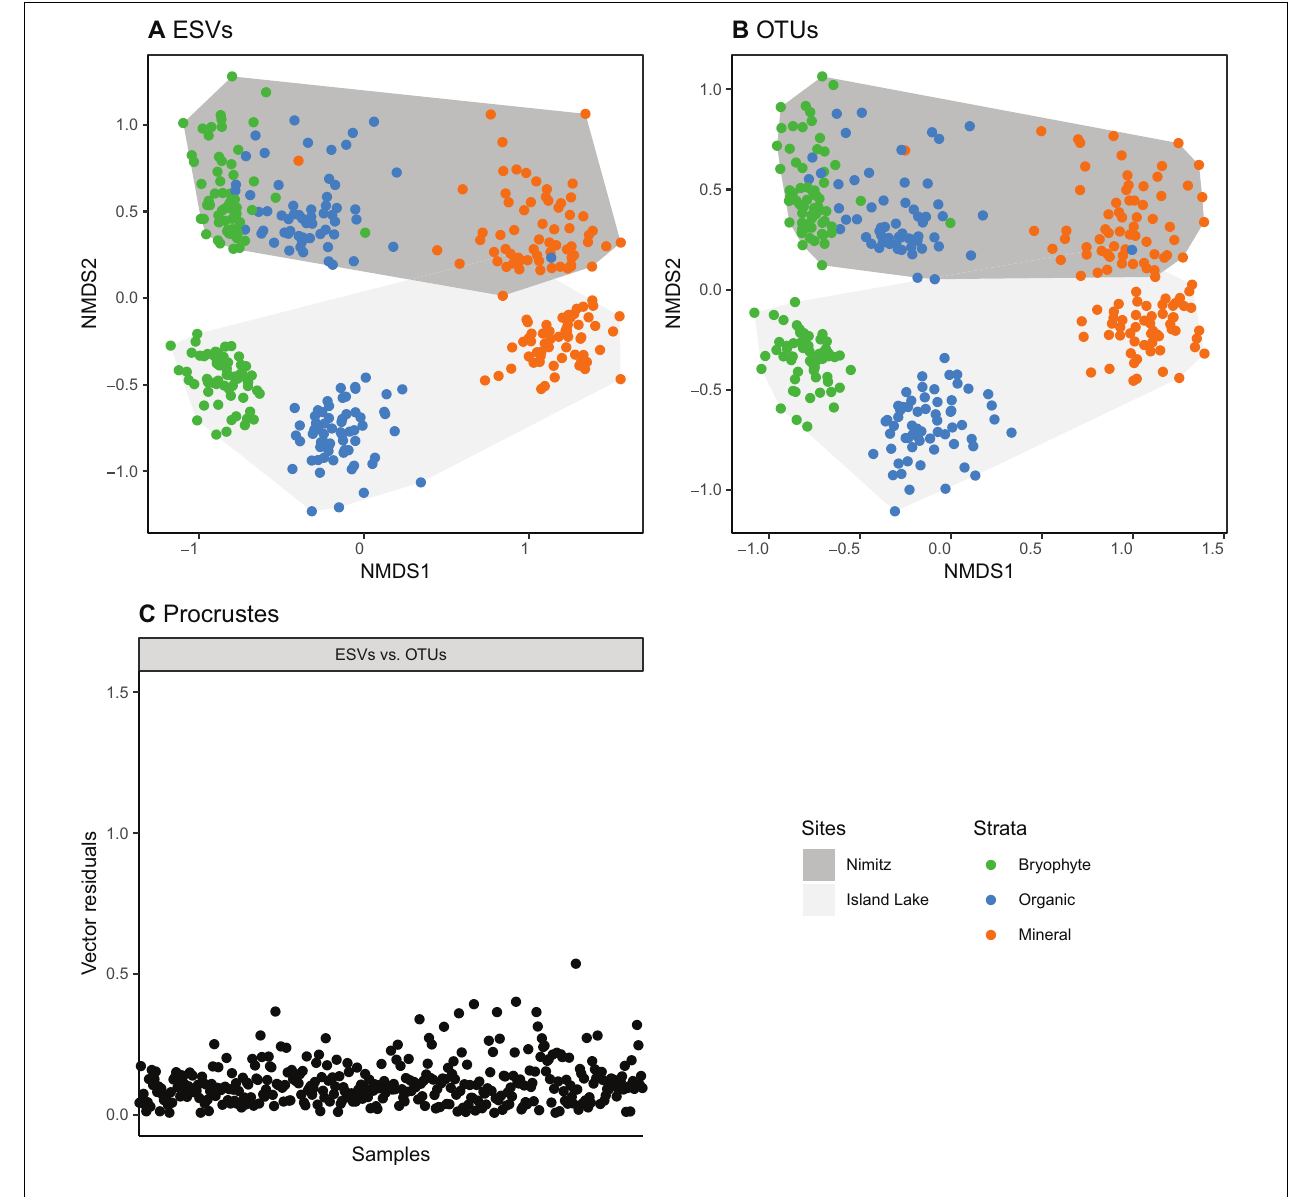
FIGURE 4 | Sample sites and soil strata are similarly distinguished using either ESV or OTU clusters. Data is from a study that assessed arthropod diversity using COI metabarcoding from forest soil (Porter et al., 2019). Parts (A,B) show that non-metric multidimensional scaling plots based on binary Bray Curtis (Sorensen) dissimilarities. A Procrustes analysis (least squares orthogonal mapping) was used in part to assess differences in the ordinations based on the analysis of ESVs and OTUs. The vector residuals plotted in (C) show the differences between the original ESV ordination and the OTU ordination. Smaller residuals indicate smaller differences between the